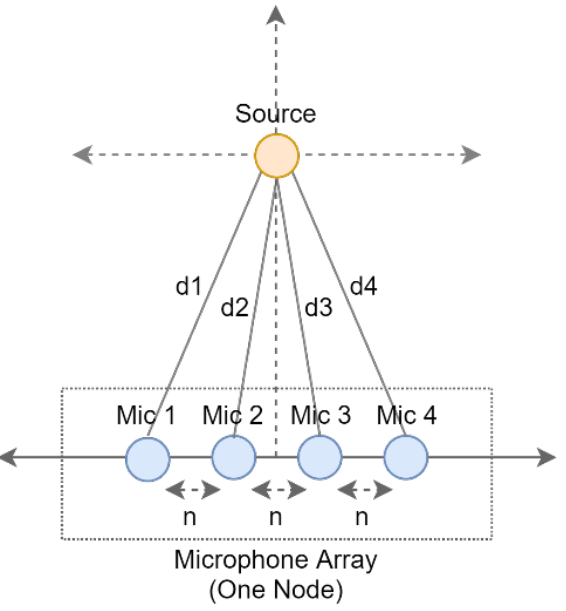
Figure 3. Microphone array geometry for a single node: four linearly spaced microphones. Dry samples are taken from Freesound (FSD50K) [48], Kaggle [49], DESED